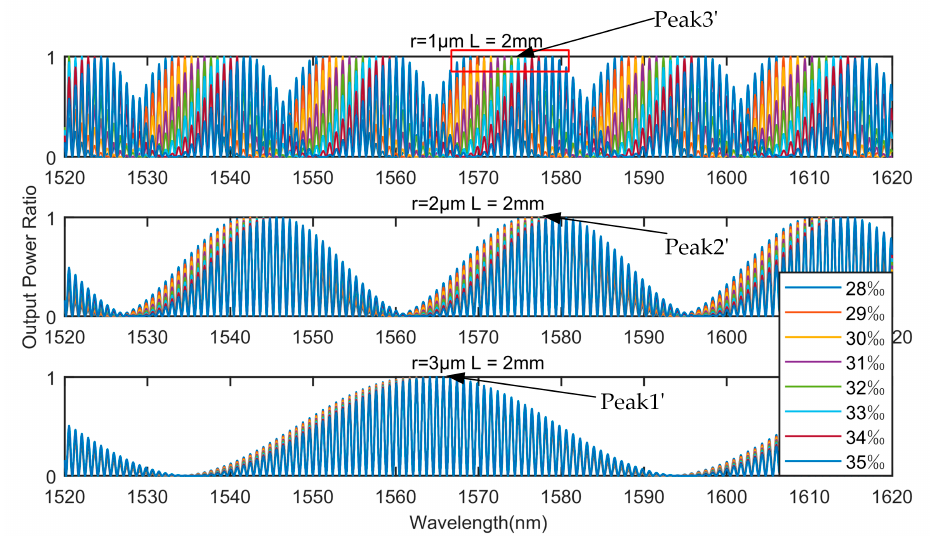
Figure 5. The results of simulation output spectra with OMCI waist length of 2 mm, arm difference of 3 mm and OM radius of 1, 2, and 3 μ m, respectively, for the salinity range of 28–35‰.